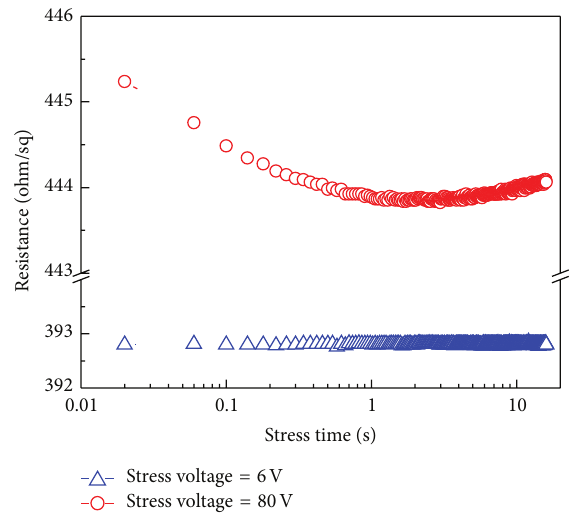
Figure 5: Normalized resistance under 6V and 80 V stress (color